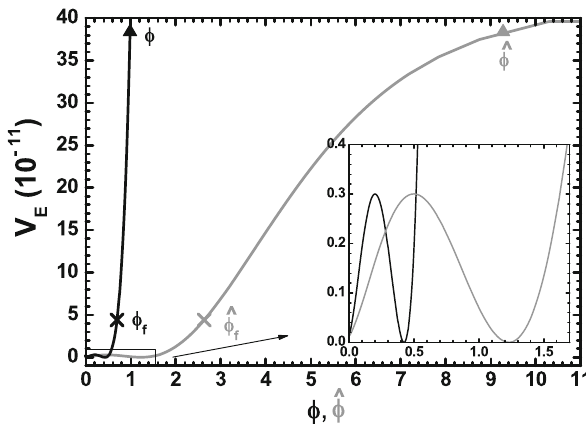
Fig. 1 Inflationary potential V E for EM4 asa functionof φ (blackline) for φ > 0 and (cid:3) φ (gray line) for (cid:3) φ > 0. We set r 12 = 0 . 4, M 2 = 0 . 1 and N = 10. Values corresponding to φ (cid:14) [ (cid:3) φ ] and φ f [ (cid:3) φ f ] are depicted. Shown is also the low- φ behavior of V E in the